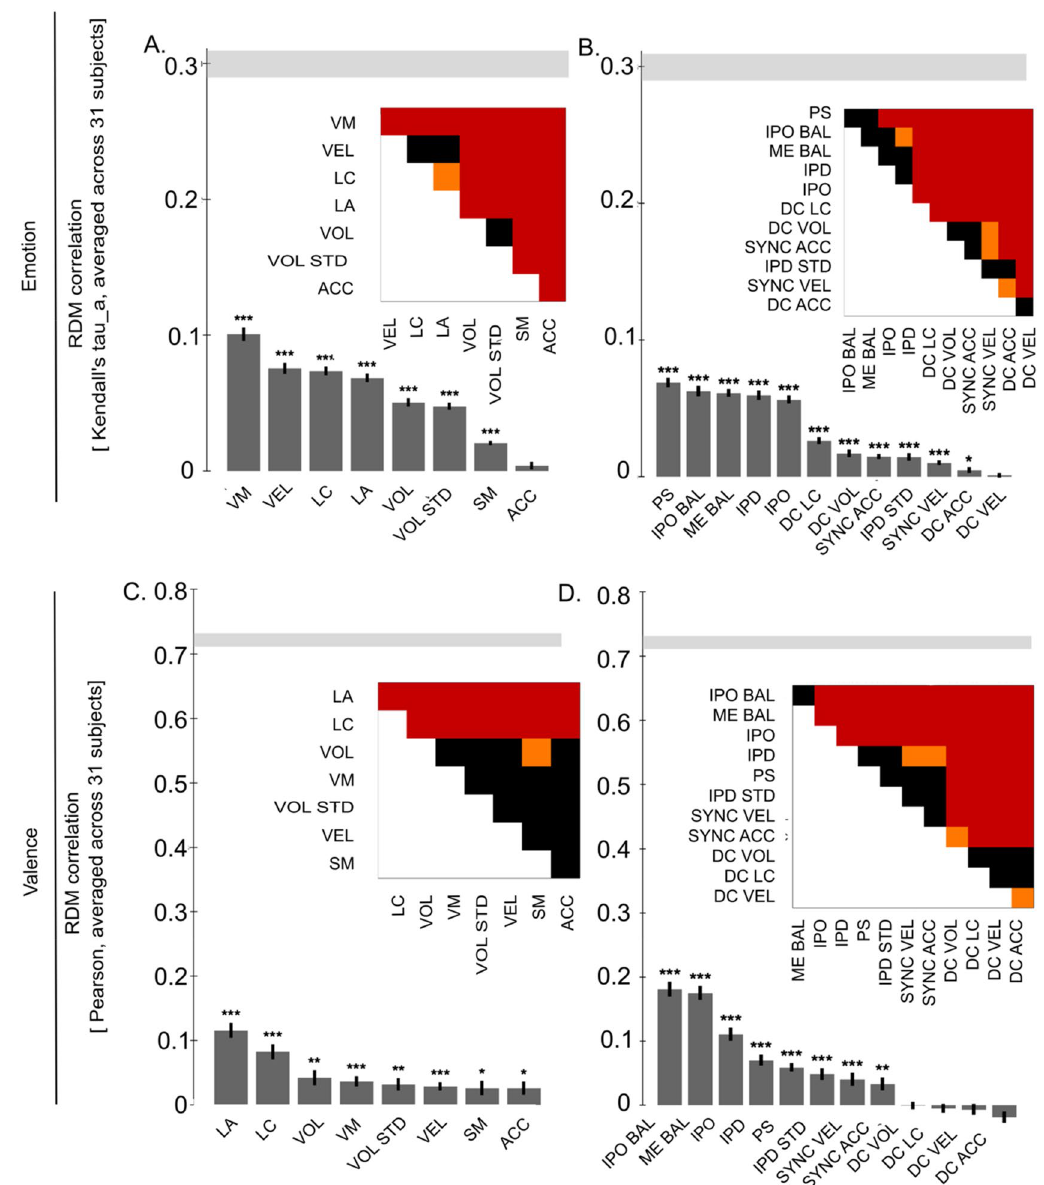
Figure 5. Relationship between behavioural RDMs and feature RDMs. ( A , C ) Intrapersonal Features; ( B , D ) Interpersonal Features; Kendall’s τ A correlation between emotion rating RDMs and Pearson correlation between valence rating RDMs. Significant correlations shown by asterisks ( ns not significant; *p < 0.05; **p < 0.01; ***p < 0.001, controlling FDR at 0.05). Lower and upper bounds of the noise ceiling are depicted by a grey bar. Pairwise comparisons indicate which feature RDMs perform significantly differently. Colour corresponds